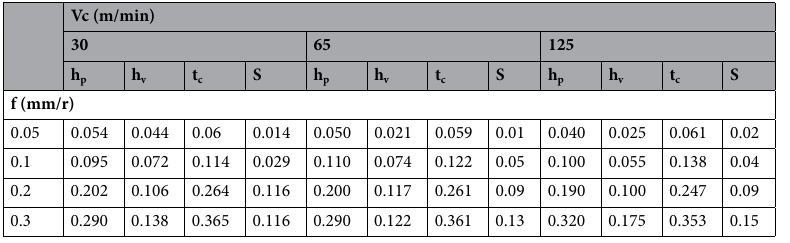
125 m/min, where the trend changes. This can be attributed to the same mechanism explained in relation to Table 10. As an average the model presents an error of 12% and for the valley values and 30% for the peak values. It can be concluded that the initial model provides reasonably good fit to the experimental results regarding the obtained cutting forces. For the chip geometry analysis, the model can be valid for a feed range between 0.20 and 0.30 mm/r. Thus, it is necessary to develop the model further to better adapt to the low feed range (0.05 and 0.10 mm/r).